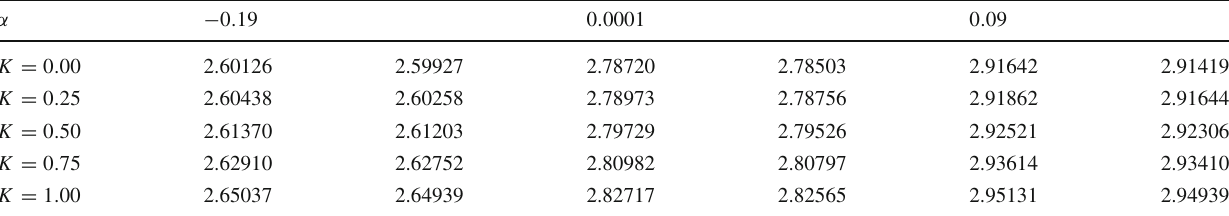
Table 3 The critical chemical potential (cid:12) c = q μ c / r s obtained from the S–L method (left column) and numerical calculation (right column) for the holographic p-wave superfluid model for chosen values of the GB factor α and various of K with the fixed mass m 2 L 2